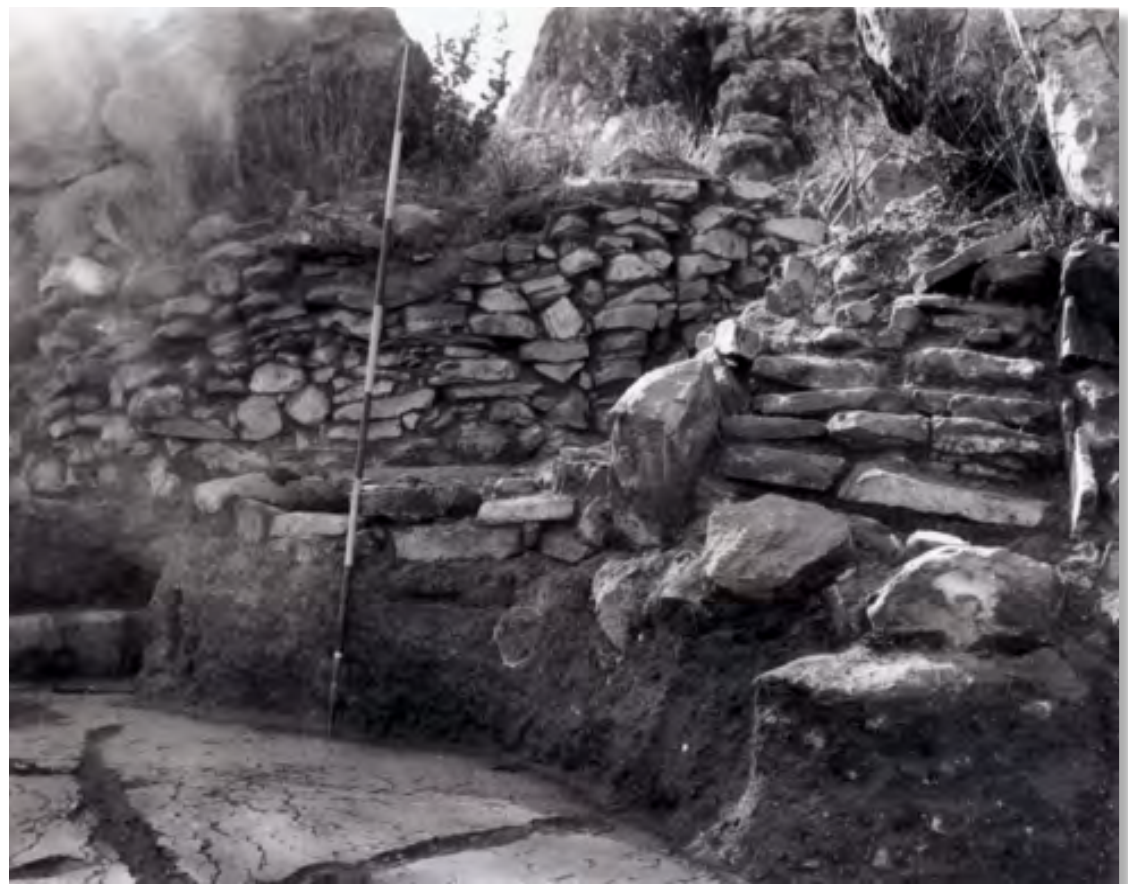
Figure 4. A terrace stonewall, constructed above a dolerite gravel floor that overlaps an underlying terrace stonewall (left); and stone steps (right) apparently belonging to a later terrace construction that was eventually partly crushed by a fallen section of the adjacent sandstone boulder (cf. similar photograph in Fouché 1937:Plate